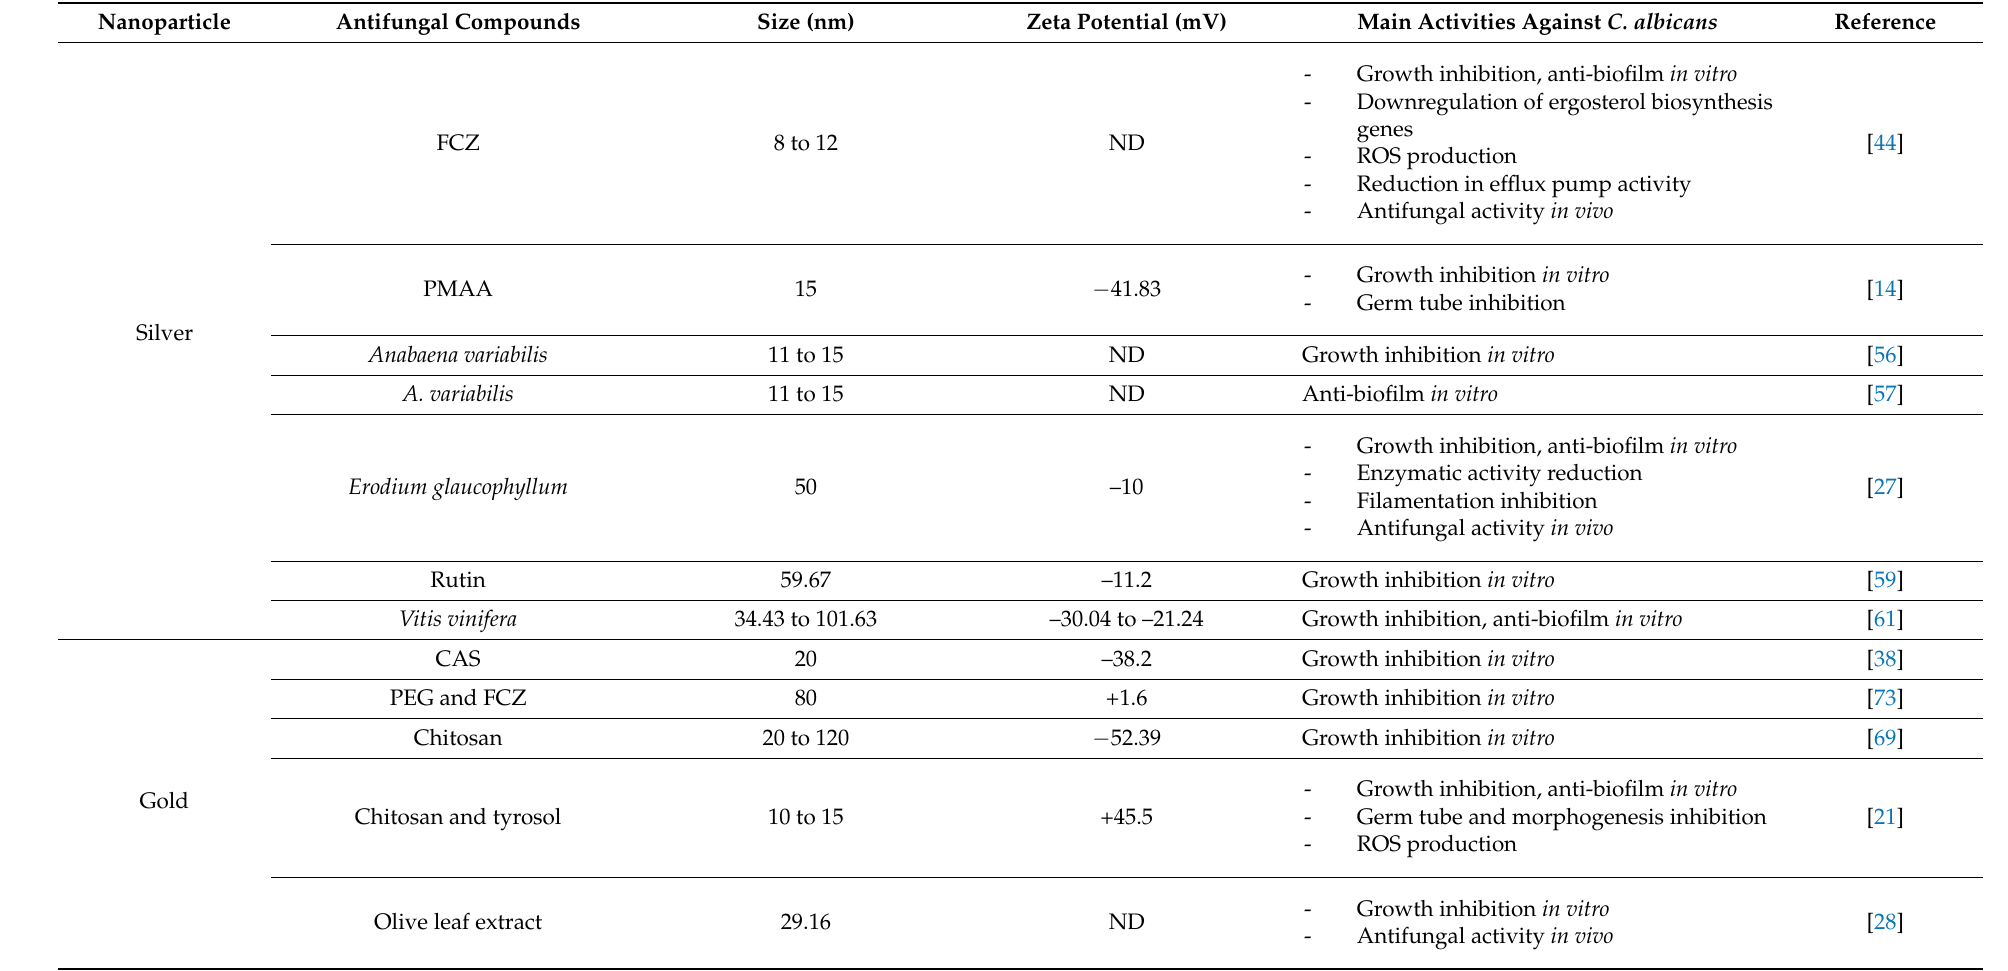
Table 1. Characteristics and main activities of metal nanoparticles against C. albicans included in the